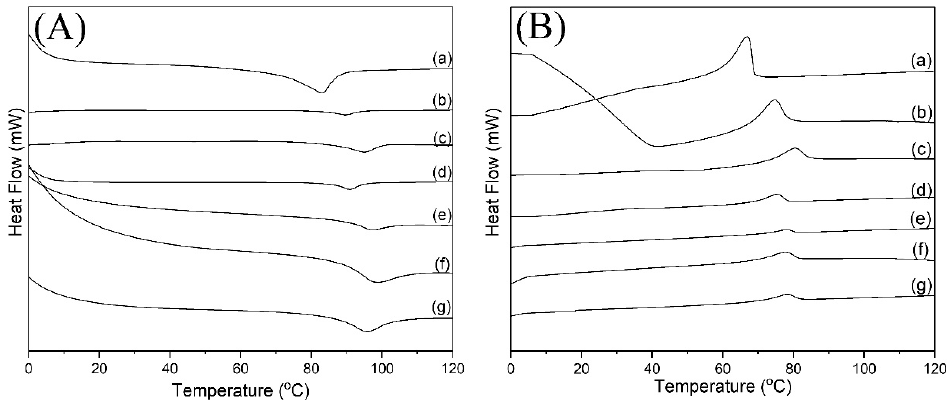
Figure 4. DSC curves of ( A ) 2 nd heating and ( B ) 1 st cooling; (a) PFDMA homopolymer, (b) 12 nm- SiO 2 (28)@PFMA, (c) 12 nm-SiO 2 (46)@PFMA, (d) 80 nm-SiO 2 (25)@PFMA, (e) 80 nm-SiO 2 (49)@PFMA,